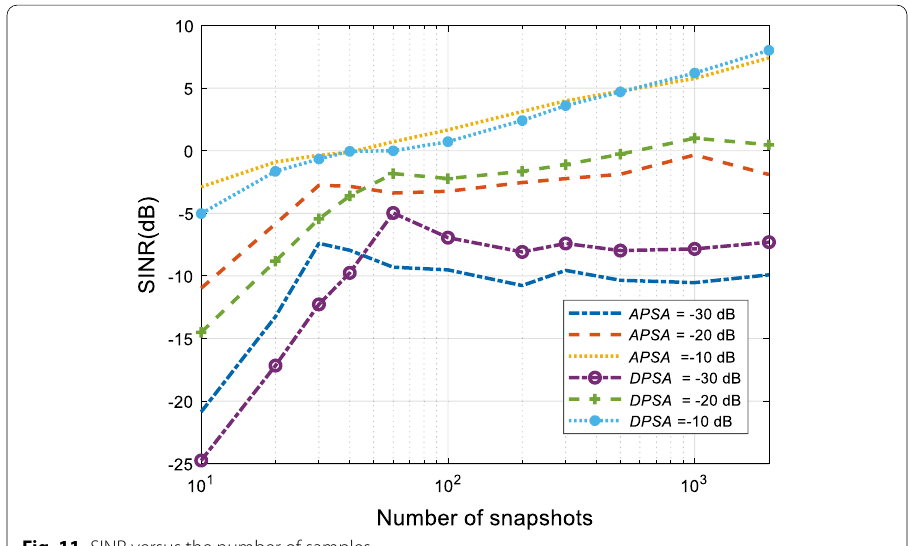
Fig. 11 SINR versus the number of